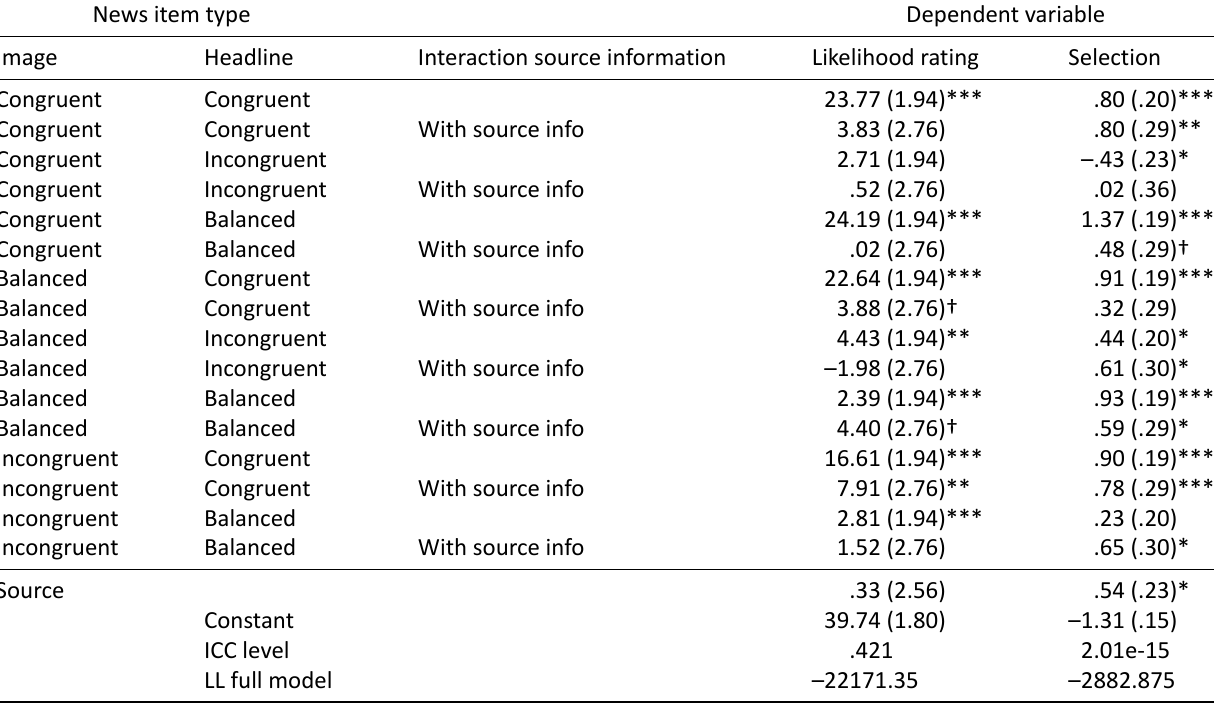
Table B1. Refugees context, multilevel models explaining peoples’ likelihood of viewing and selection of a news items, interacted with source